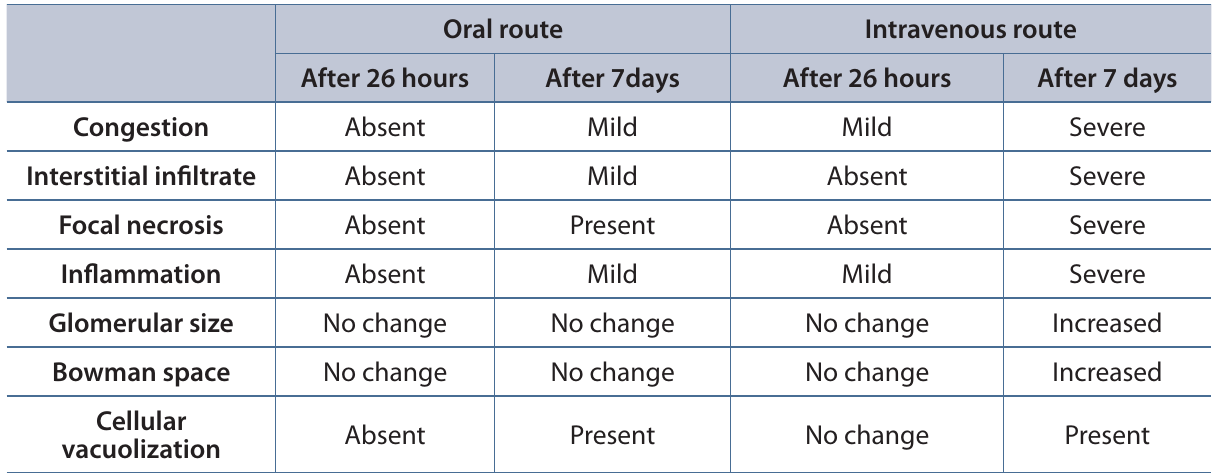
Table 2. Histopathological effect of DON on kidney after oral and intravenous administration